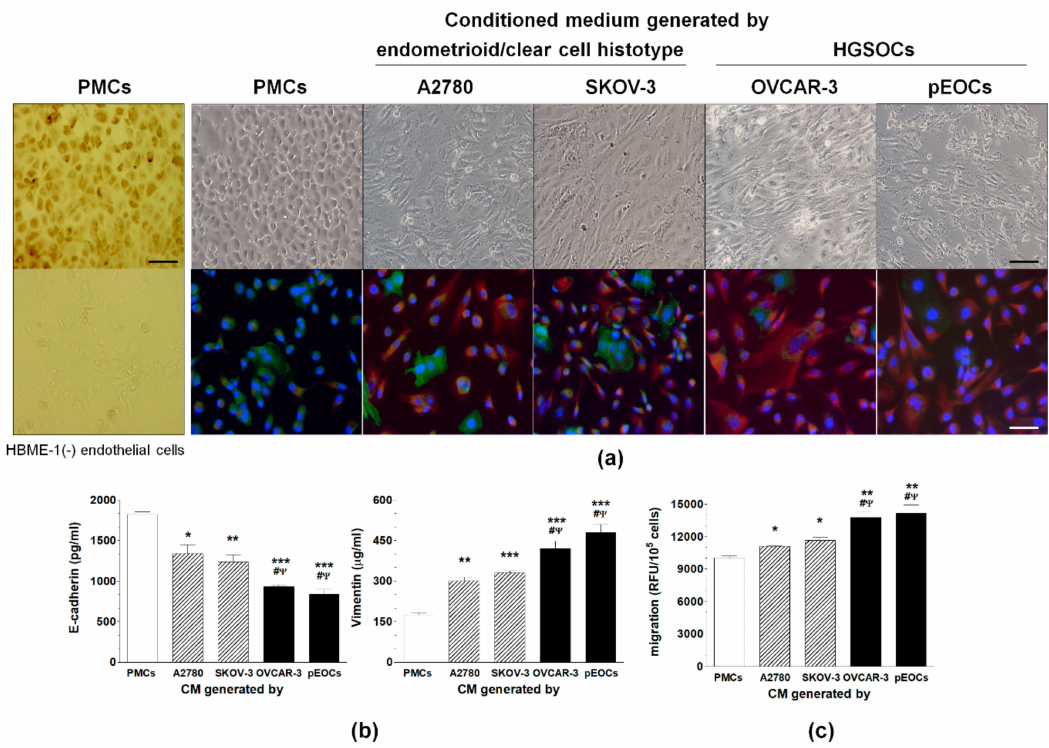
Figure 1. The induction of mesothelial-mesenchymal transition (MMT) in the peritoneal mesothelial cells (PMCs) exposed to autologous and cancer-derived conditioned medium (CM). ( a ) Representative pictures showing the development of spindle-shaped morphologies in the PMCs and confirmed by changes in E-cadherin (green) and vimentin (red) expression (the nuclei are stained blue). The very left panel of pictures shows the identification of PMCs according to the expression of HBME-1 antigen (brown cytoplasm). Below, HBME-1-negative endothelial cells (HMEC-1). Scale bars = 50 µ m. ( b ) Changes in the E-cadherin and vimentin concentration in the cell lysates from the PMCs exposed to autologous and cancer-derived CM. ( c ) Migration of the PMCs undergoing the cancer-induced MMT. Experiments were performed with eight separate cultures of PMCs obtained from di ff erent donors, with eight separate cultures of primary epithelial cancer cells (pEOC), and with eight separate cultures of each established cancer cell line. The results are expressed as the mean ± SEM. *, p < 0.05 vs. PMCs; **, p < 0.01 vs. PMCs; ***, p < 0.001 vs. PMCs; # , p < 0.05 vs. A2780; Ψ , p < 0.05 vs. SKOV-3. RFU, relative fluorescence units.